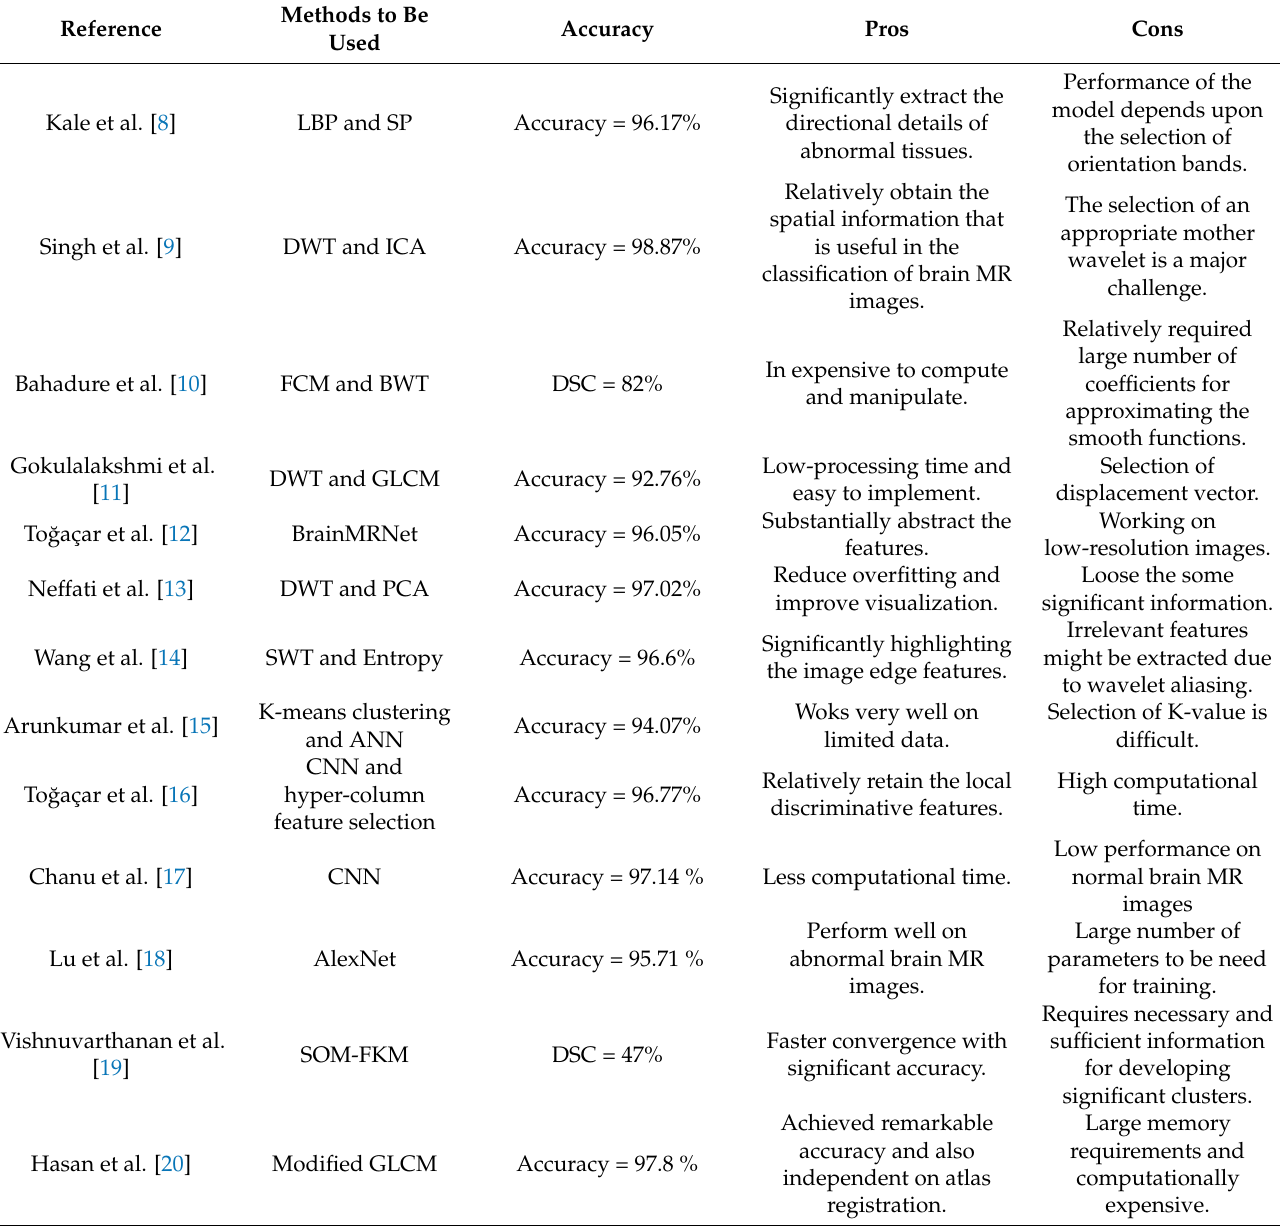
Table 1. Summary of the